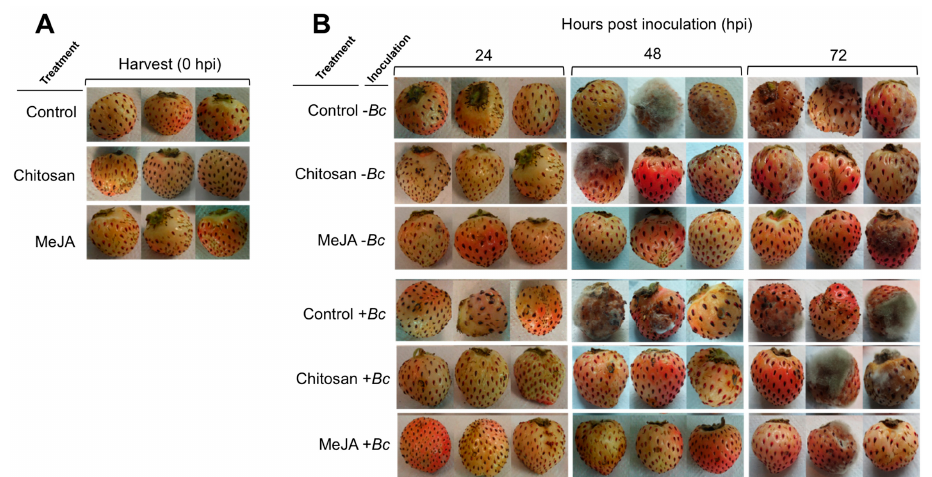
Figure 1. Symptoms and signs evolution in Fragaria chiloensis fruit treated with methyl jasmonate (MeJA) and chitosan infected with Botrytis cinerea at different hours post inoculation (hpi). Representative photographs of three fruit from the total for each treatment (control, chitosan, and MeJA) and inoculation (with (+ Bc ) or without (– Bc ) B. cinerea spores) at harvest ( A ), and from 24 to 72 hpi ( B ). For experimental details see the Materials and Methods Section.